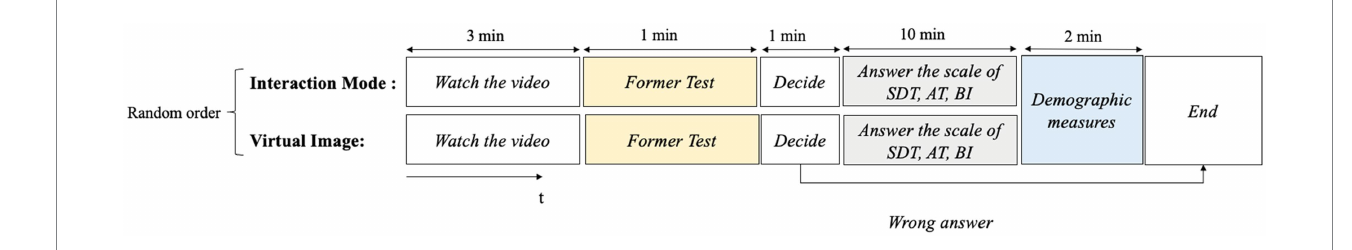
FIGURE 4 Procedure of the experiment per